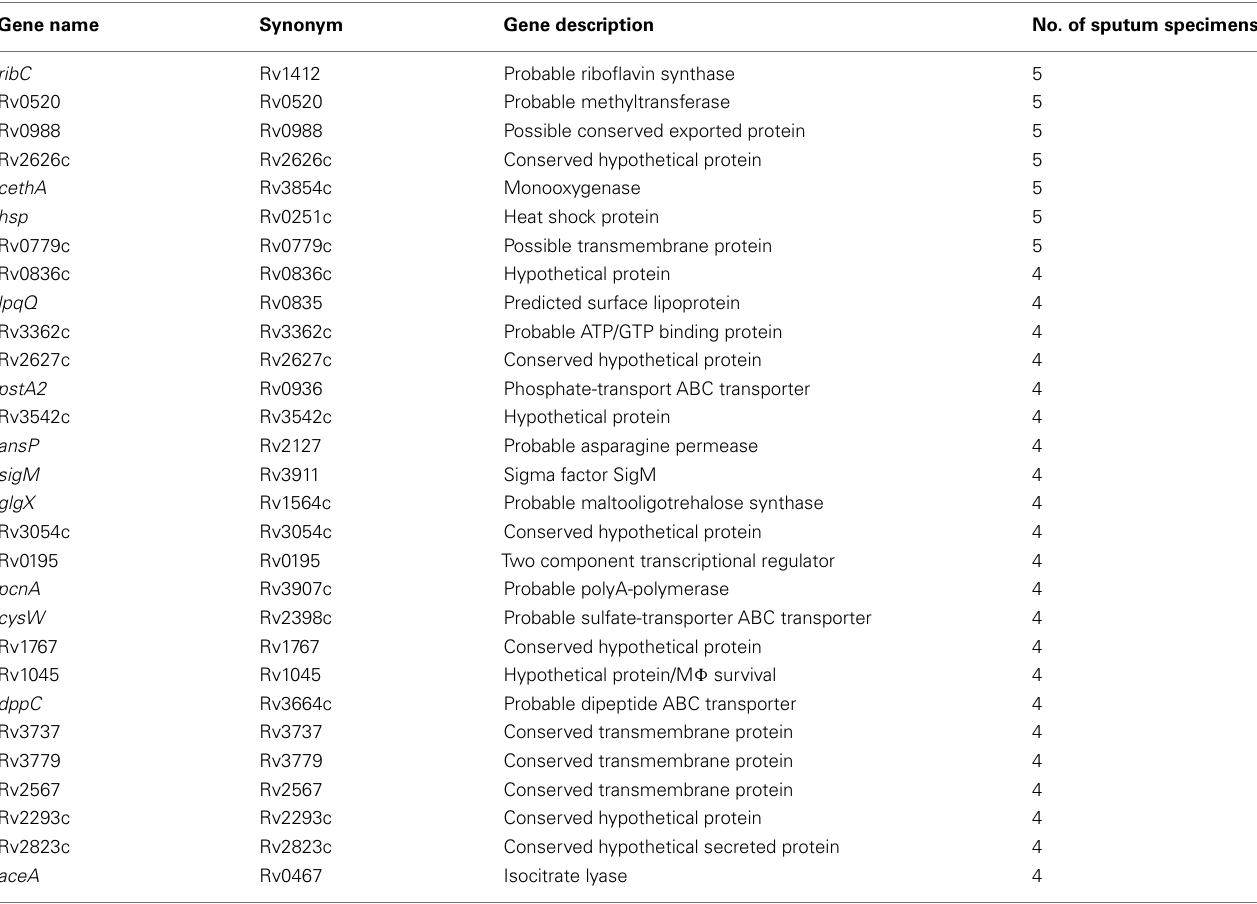
Table 1 | Mycobacterium tuberculosis ORFs corresponding to mRNAs detected either in four or five sputum specimens and potentially expressed in response to growth in the lung.